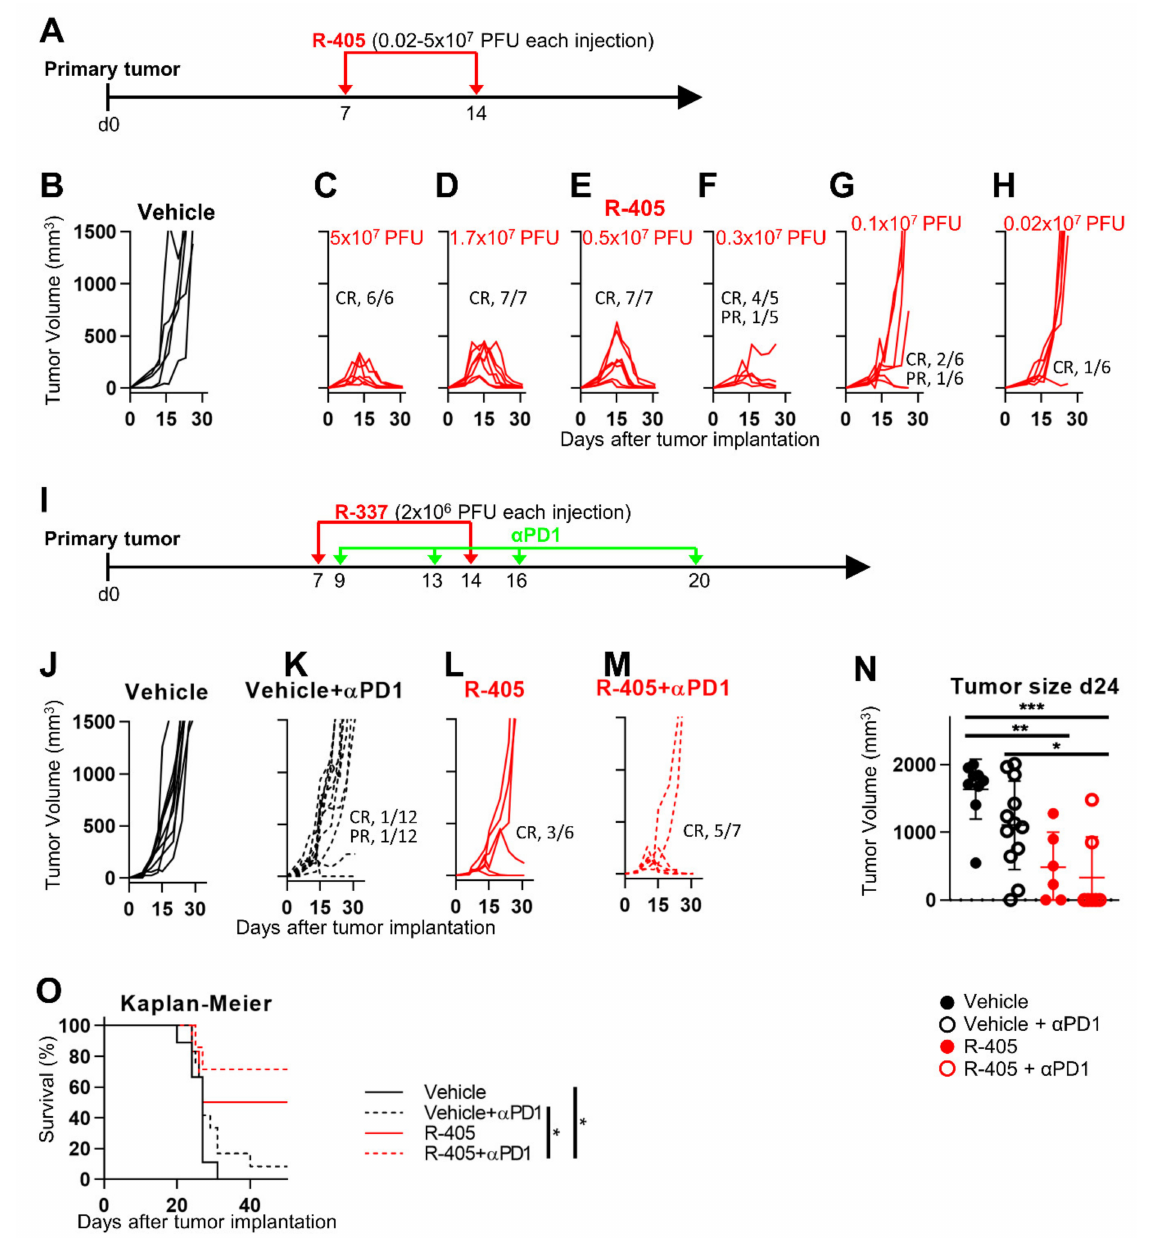
Figure 5. Therapeutic effects of R-405 in combination with anti-PD-1 antibody on the growth of LLC1-PSMA tumors. ( A ) Schedule of the monotherapy treatments. Mice were implanted with LLC1-PSMA cells. At d 7 after implantation, when tumors reached the average volume of 70–100 mm 3 , mice received 2 i.t. injections of R-405 at indicated dosages ranging from 5 × 10 7 to 2 × 10 5 PFUs or vehicle at 7 d time interval. ( B – H ) Tumor growth curves at indicated dosages. ( I ) Schedule of the combination treatments. Mice received two i.t. injections of R-405 at 7 d interval and 4 i.p. injections of anti-PD-1 at 3–4 d intervals. ( J – M ) Tumor growth curves in mice receiving the monotherapies or combination treatment. Figures in panels indicate the number of mice exhibiting complete response (CR) or partial response (PR). ( N ) Volumes of the primary tumors at d 24 after implantation. Circles correspond to individual mice, horizontal line indicates the mean value, and vertical bars ± SD. ( O ) Kaplan-Meier survival curves of the four indicated groups of mice. ( N , O ) Statistical significance was calculated by means of the ANOVA test with Tukey’s correction ( N ) or Log-rank (Mantel-Cox) test with Bonferroni’s correction ( O ), and expressed as * = p -value < 0.05; ** = p -value < 0.01; *** = p -value < 0.001. Color codes: mice treated with vehicle (black) or R-337 (red). Full circles and continuous lines, monotherapies. Open circles and dotted lines, combination